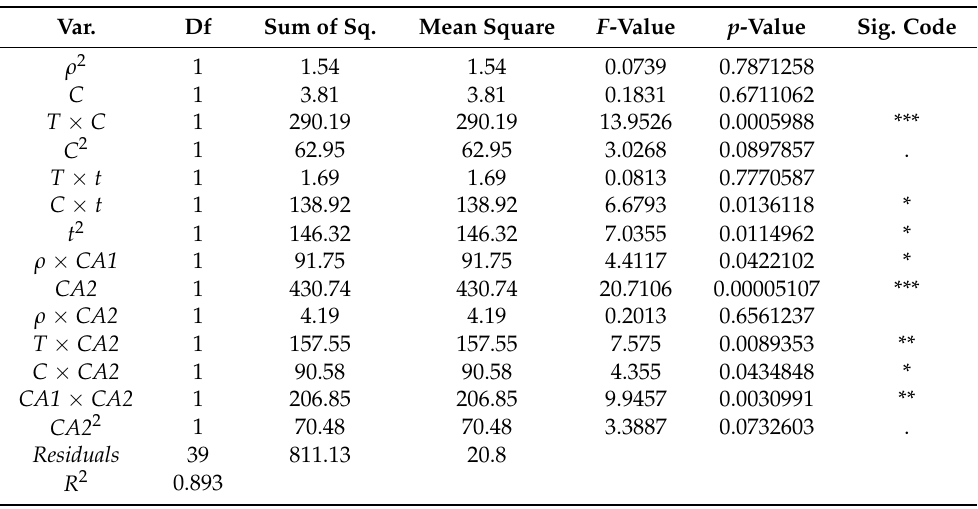
Table 5. ANOVA table for the “ Th ” quadratic